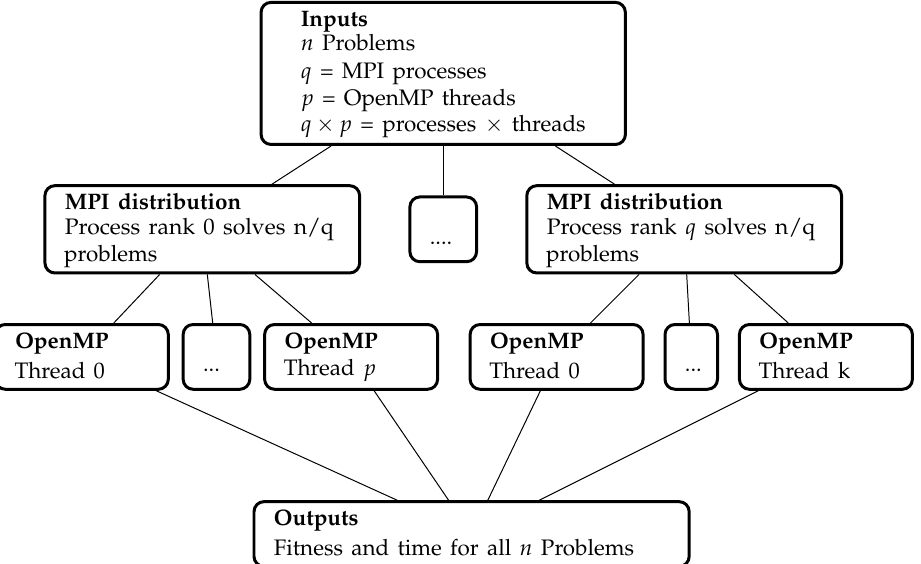
Figure 2. The parallel algorithm scheme based on resource decomposition in two